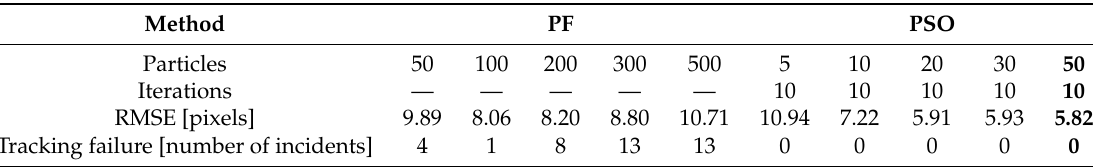
Table 1. Errors for compared